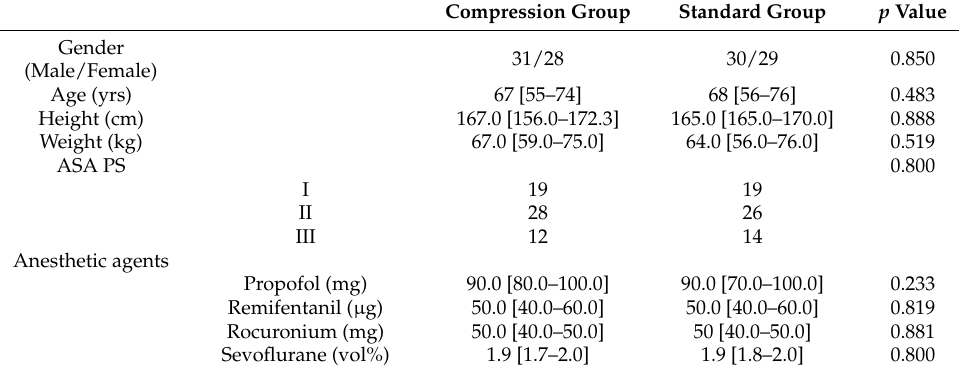
Table 1. Demographic data.